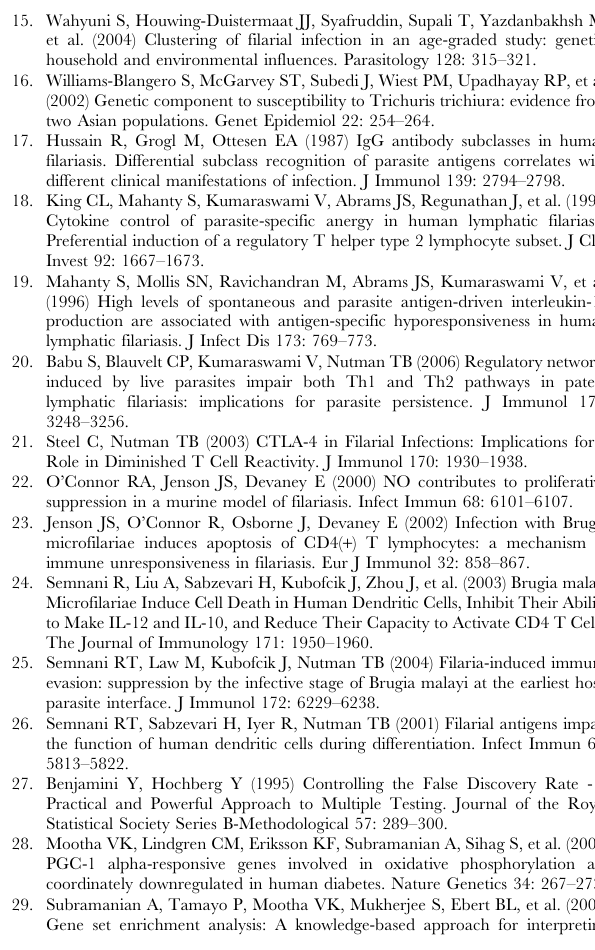
Figure S3 GSEA analysis of canonical pathways in MfAg-driven CD4 + endemic cells. Gene Set Enrichment Analyis (GSEA) of canonical biological pathways in the microfi- larial Ag (MfAg) stimulated CD4 + T cells of endemic filarial- infected patients. The heat map represents the values of differentially expressed genes in each of the 3 patients to MfAg (on the right) and to the corresponding media values (on the left). Genes in brown represent those upregulated to MfAg with respect to media while genes in blue are downregulated. Enrichment of biological functions was determined by clustering analysis showing significant differential expression in the CD4 + T cells for upregulated genes (green bars, top right panel) and downregulated genes (blue and purple bars, bottom right panel). Each bar in the plot represents the percent enrichment of a particular pathway (top axis) and an asterisk represents a significant corresponding p- value (FDR , 0.1) for the pathway (bottom axis). (TIF) Figure S4 GSEA analysis of canonical pathways in MfAg-driven CD4 + expatriate cells. Gene Set Enrichment Analyis (GSEA) of canonical biological pathways in the microfi- larial Ag (MfAg) stimulated CD4 + T cells of expatriate filarial- infected patients. The heat map represents the values of differentially expressed genes in each of the 3 patients to MfAg (on the right) and to the corresponding media values (on the left). Genes in brown represent those upregulated to MfAg with respect to media while genes in blue are downregulated. Enrichment of